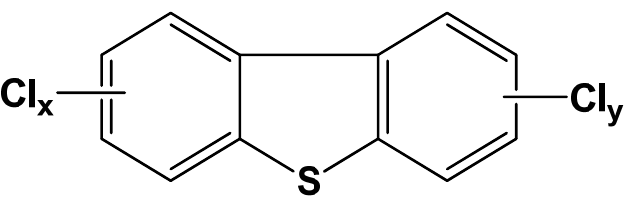
Figure 1. The structural formulas of PCDTs.